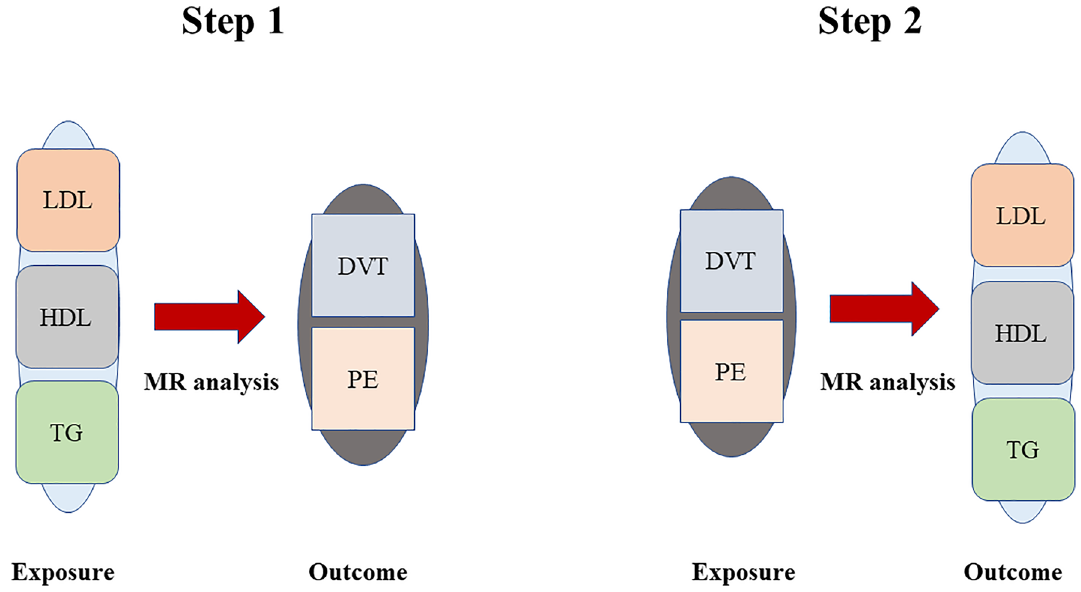
Figure 1. Analysis flow chart. We performed bidirectional MR analysis of classical lipids (LDL, HDL and TG) and VTE (DVT and PE). First, we used classical lipids (LDL, HDL and TG) as exposure variables to conduct two-sample MR analysis with VTE (DVT and PE). In addition, to further clarify whether VTE affects lipids, we used VTE as an exposure variable to analyse the causal relationship between VTE and classical